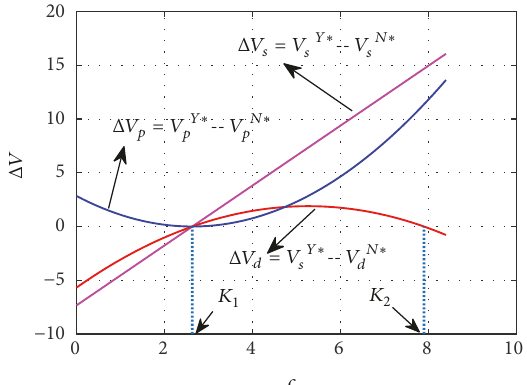
Figure 10: Pareto improvement effect of the transaction fee for the cost-sharing